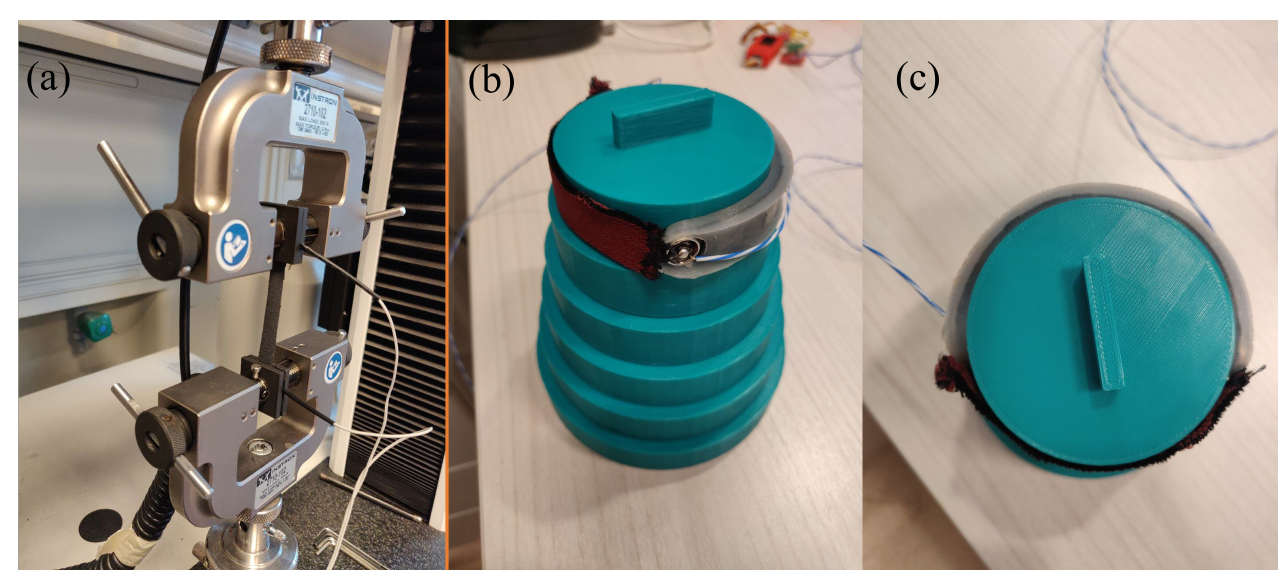
Figure 2. ( a ) Picture of the experimental setup for the metrological characterization of the stem growth sensor.In particular, the Instron clamps and the sensor positioning are shown; ( b ) side-view and ( c ) top-view of the 3D-printed discs used for assessing the fruit growth sensor’s behavior when simulating different fruit diameters at different growth stages (ranging from 65 mm to 115 mm). Additionally, the sensor’s placement for the trials is